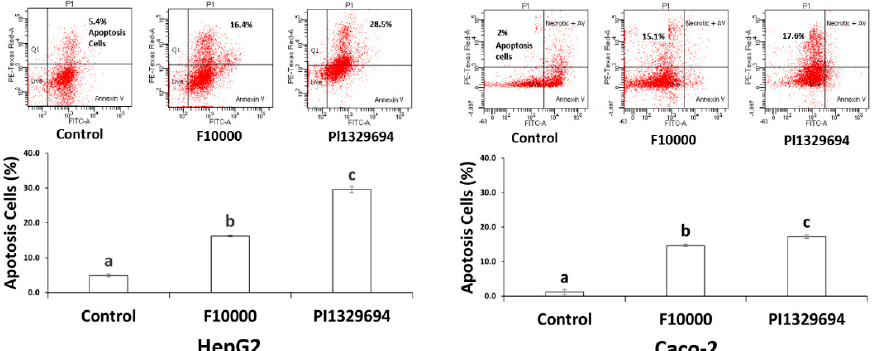
Figure 4. Apoptosis induced by representative sorghum phenolic extracts in HepG2 and Caco-2 cell lines. Cells were treated with sorghum phenolics extracted from the representative sorghum accessions PI329694 and F10000 at 0–200 μ M GAE for up to 72 h, and then apoptosis was analyzed by FITC annexin V staining protocol. Values are expressed as Mean ± SD ( n = 3), Means with different alphabetical letters differ significantly, p ≤ 0.05.